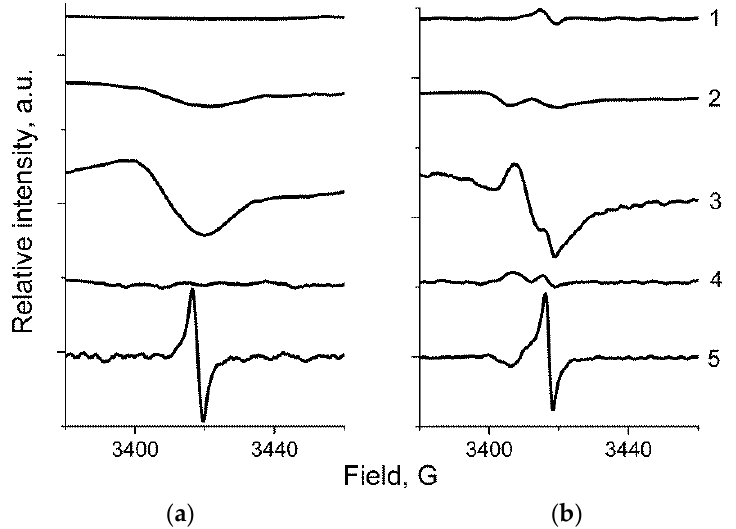
Figure 5. ESR spectra for fired PbO·ZnO·P 2 O 5 coarse glass before ( a ) and after ( b ) 0.9 MGy γ -irradi- ation. 1 — pure glass; 2 — with 2 wt. % graphite PMM 11; 3 — with 10 wt. % graphite PMM 11; 4 — with 2 wt. % Cloisite 30B; 5 — with 10 wt. % Cloisite 30B.